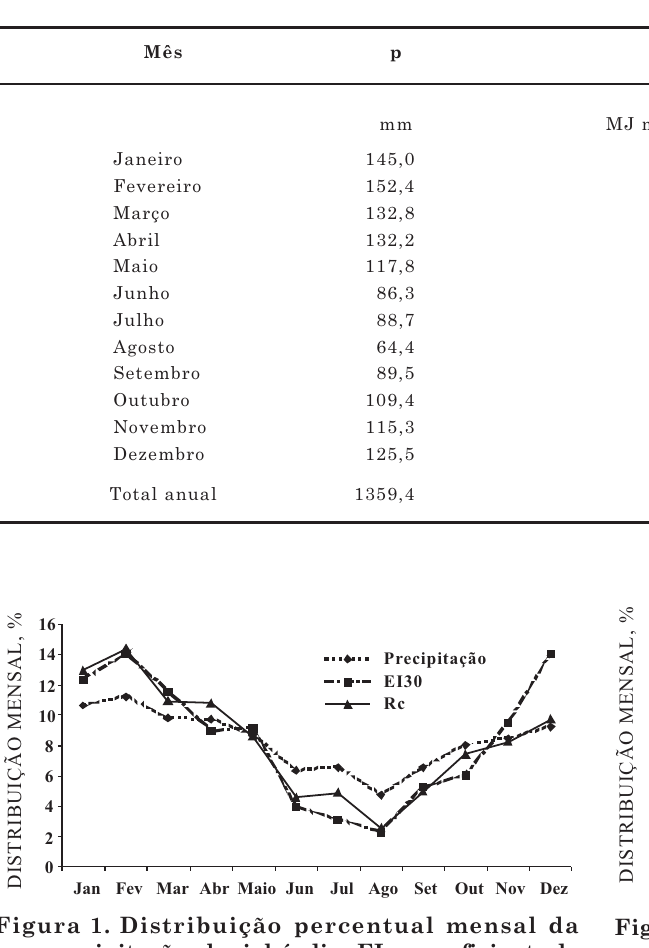
Quadro 3. Equações de regressão linear entre o índice EI